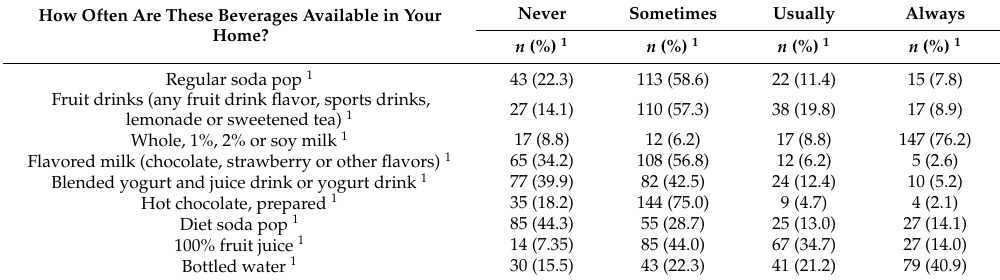
Table 2. Parent-reported frequency of availability of beverages at home in a cross-sectional survey.